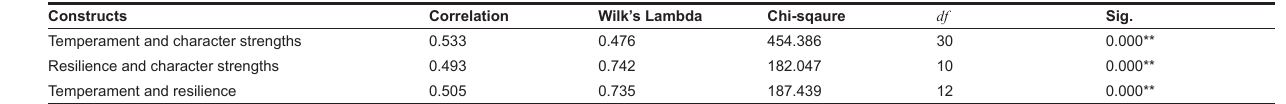
TABLE 2 Canonical Correlations and test for remaining correlations